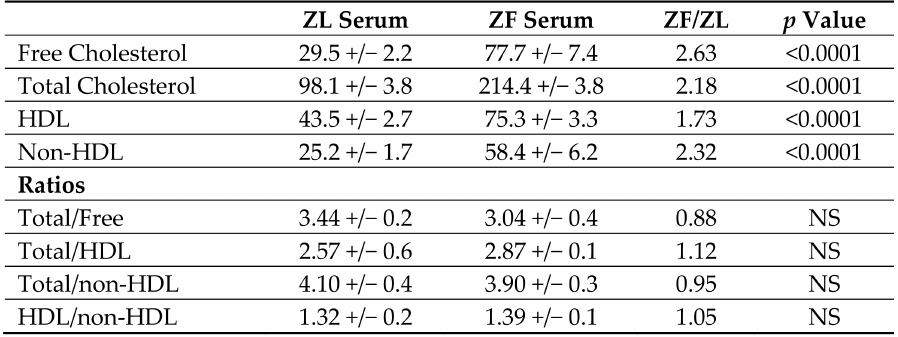
Table 3. The total and free cholesterol, as well as the HDL and LDL contents in the female ZF serum, are significantly higher than in the ZL serum, but the HDL / LDL ratios are not significantly di ff